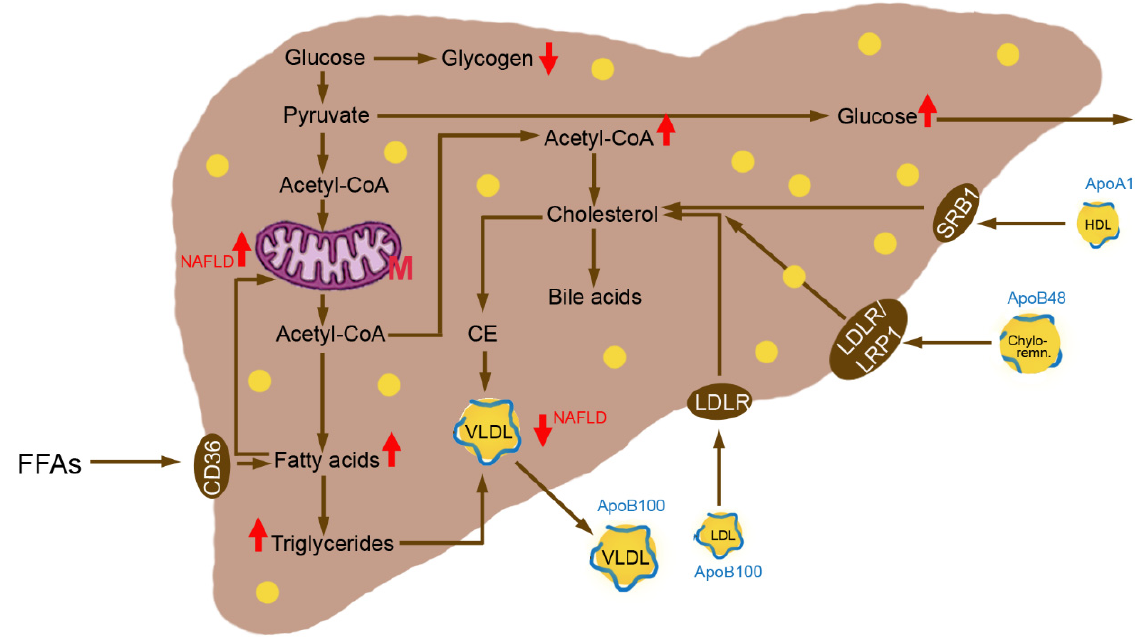
Figure 2. Changes in hepatic metabolism in insulin resistance and Non-Alcoholic Fatty Liver Disease (NAFLD). Glucose is metabolized to acetyl-CoA and used for synthesis of fatty acids and cholesterol. Free Fatty Acids (FFAs) are taken up by the CD36 receptor. The increased intracellular FA levels activate β -oxidation in the mitochondria. Due to the defective function of the respiratory chain in NAFLD, generation of reactive oxygen species is increased and induces inflammation. Excess Triglycerides (TGs) may accumulate in the hepatocytes or be exported into the blood. The export of TGs and cholesterol, however, is decreased in NAFLD due to impaired VLDL synthesis. Gluconeogenesis and hepatic output of glucose continues similar to the fasted condition. Abbreviations: Apo, apolipoprotein; Chylo-remn., Chylomicron Remnants; HDL, High-Density Lipoprotein; LDLR, LDL Receptor; LRP1, LDLR-Related Protein 1; M, Mitochondrion; SRB1, Scavenger Receptor Class B Type 1; VLDL, Very-Low-Density